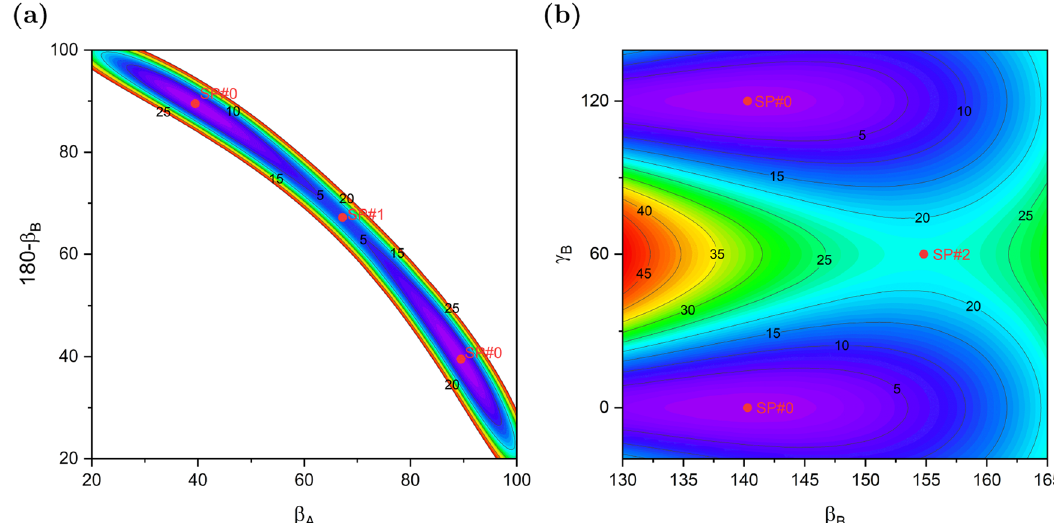
Fig. 2 Shape of the potential energy surface. Contour plots [cm − 1 ] of the PES in the region of the global minimum, SP#0, and the lowest saddle points, SP#1 and SP#2, with the interaction energy shifted to be zero at the global minimum. Panel a displays the region of the hydrogen-bond donor – acceptor interchange path between two symmetry-equivalent minima, SP#0, through SP#1. The Euler angles β A and β B are the angles (in degrees) between the C 3 axes of the monomers and the vector R joining the COMs of the monomers and oriented from A to B. The remaining Euler angles α B = 180°, γ A = 60°, and γ B = 0° are fi xed at their equilibrium values and the distance R is optimized to minimize the interaction energy. Panel b displays the γ B rotation of the acceptor monomer about its C 3 axis through the saddle point SP#2 for a range of β B values. The angles α B = 180° and γ A = 60° are fi xed, β A and R are optimized.